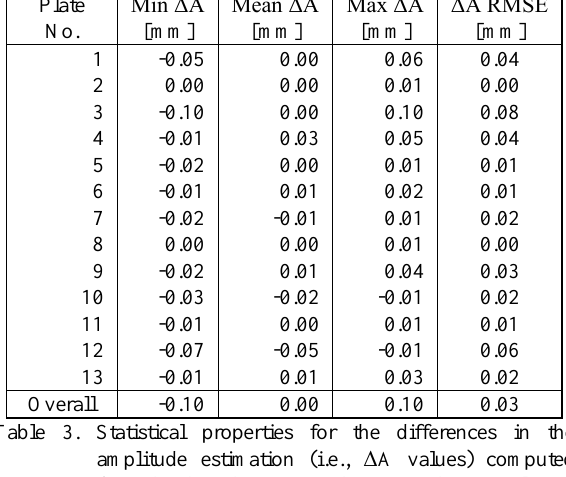
Table 3. Statistical properties for the differences in the